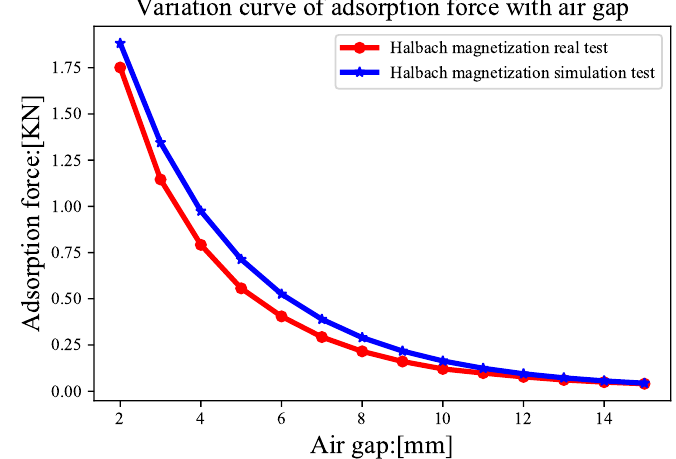
Figure 21. Comparison of Halbach magnetization adsorption forces.